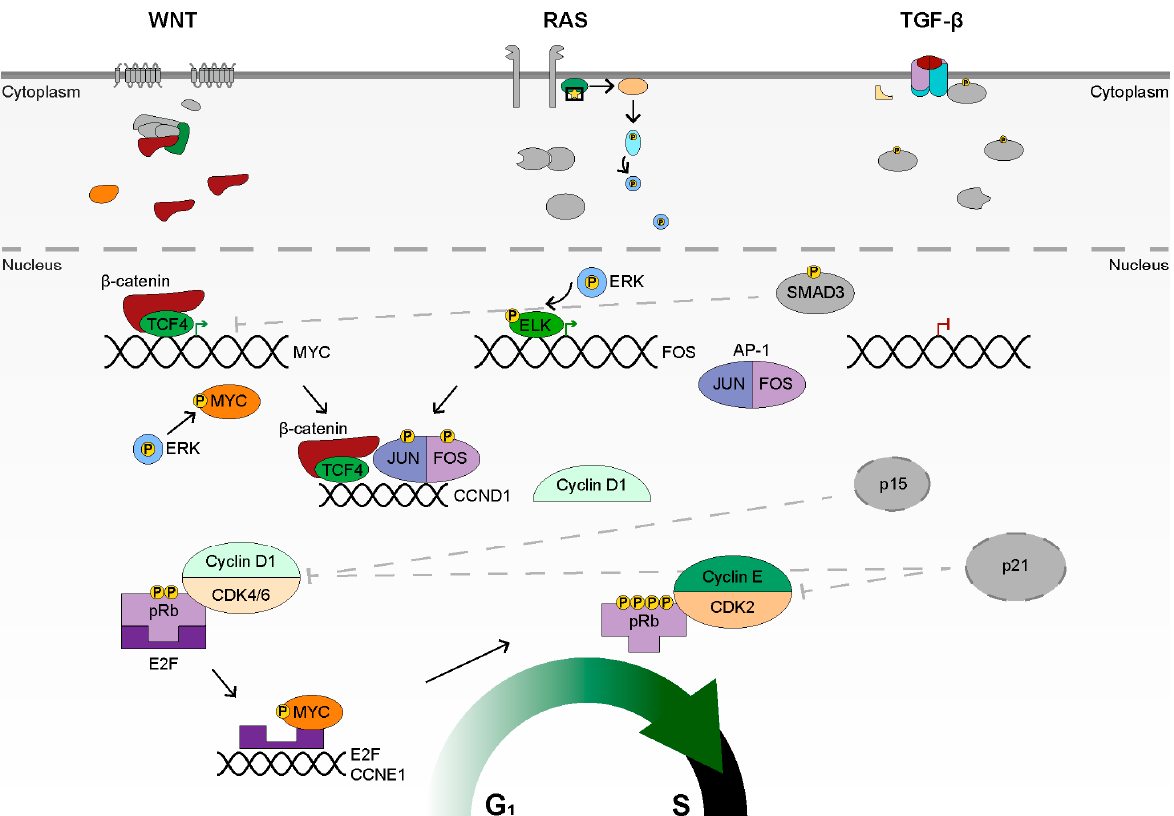
Figure 4. Signaling Overview in Sporadic Colon Cancer. Activated WNT signaling, via mutations in APC or CTNNB1 , results in constitutive formation of β cat/TCF4 complexes, which drive WNT target gene expression, such as MYC and CCND1 . Activated RAS signaling, via mutations in K-RAS , result in activation of ERK, which phosphorylates MYC, as well as the R-SMADs, inhibiting SMAD migration to the nucleus (not shown). ERK also phosphorylates ELK, which results in expression of FOS . JUN is regulated by the JNK cascade (not shown), and binds to FOS, forming the AP-1 tran- scription factor. AP-1 and β cat/TCF4 drive expression of CCND1 . Cyclin D1 binds to CDK4 or CDK6 and phosphorylates pRb, causing the release of E2F. E2F, with MYC, drives the expression of other E2F genes and CCNE1 . Cyclin E binds to CDK2, which fully phosphorylates pRb, leading to pro- gression into S-phase. The TGF- β pathway is inactivated due to mutation, though low levels of phosphorylated R-SMAD may be found in the nucleus. The cell cycle inhibitors, p15 and p21, which would be expressed given active TGF- β , cannot inhibit CDK4/6 or CDK2, and are in grey.